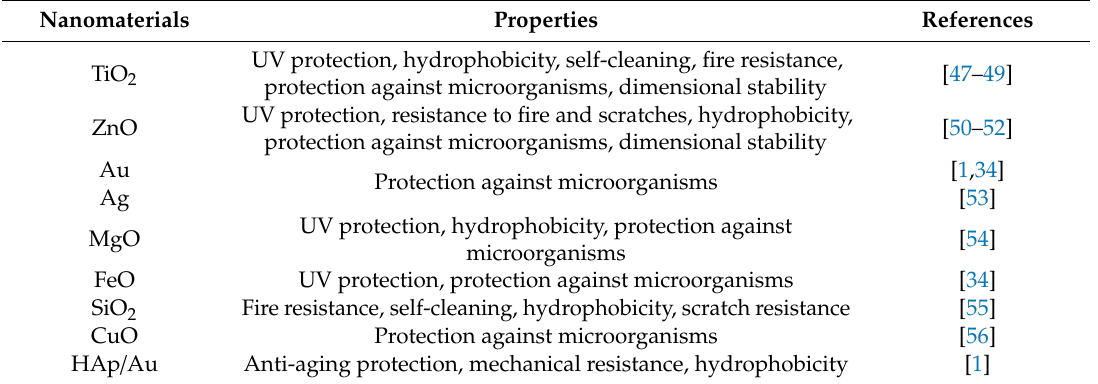
Table 1. Nanoparticles used in the literature as possible enhancers for wood and their